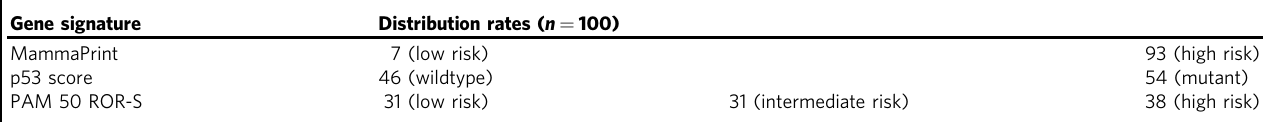
Table 3 Molecular pro fi les in the discovery